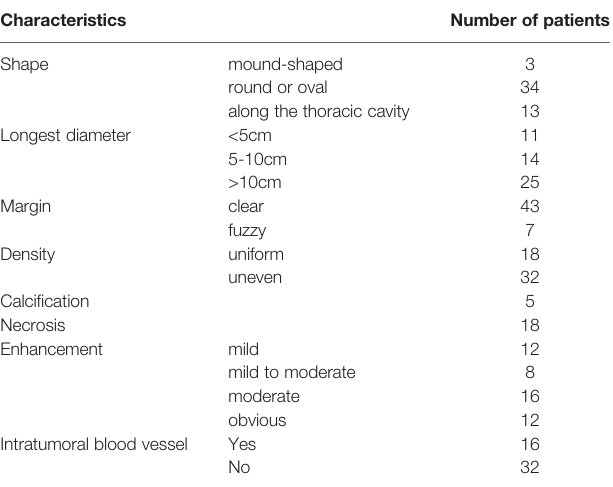
TABLE 4 | CT features of the 50 patients.